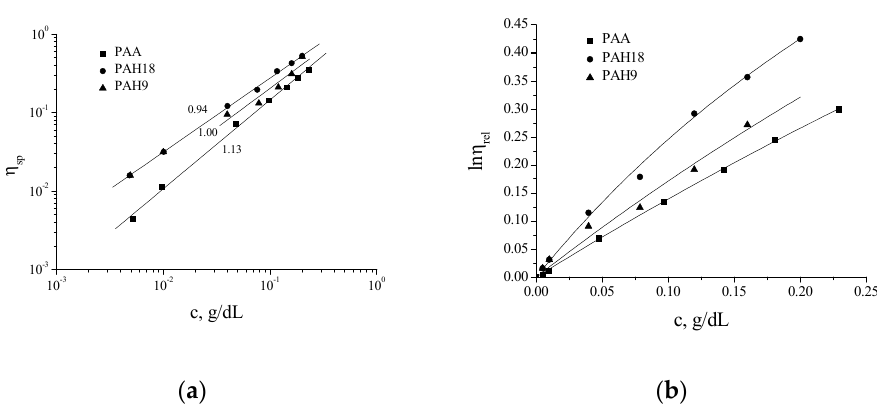
Figure 2. ( a ) Specific viscosity as a function of polymer concentration (the numbers indicate the values of the slopes), and ( b ) logarithm of relative viscosity vs. polymer concentration.